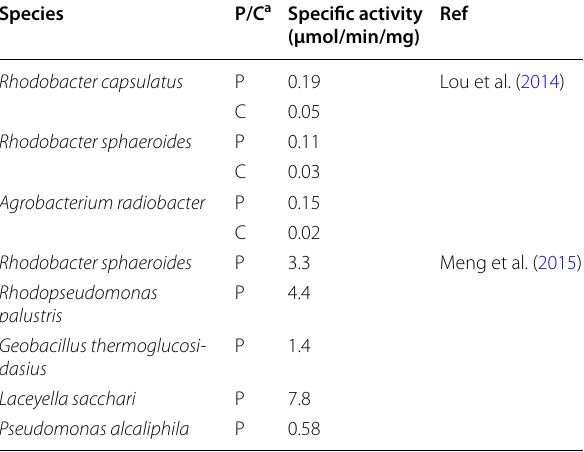
a Indicates the enzyme condition at 37 °C and pH 7.5 for characterization. P means the ALAS was purified and C means that crude enzyme was